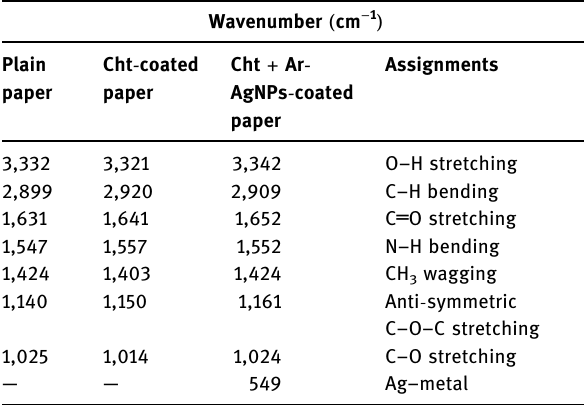
Table 2: FT - IR analysis of the plain paper, chitosan - coated paper, and chitosan with agar - mediated AgNPs - coated paper